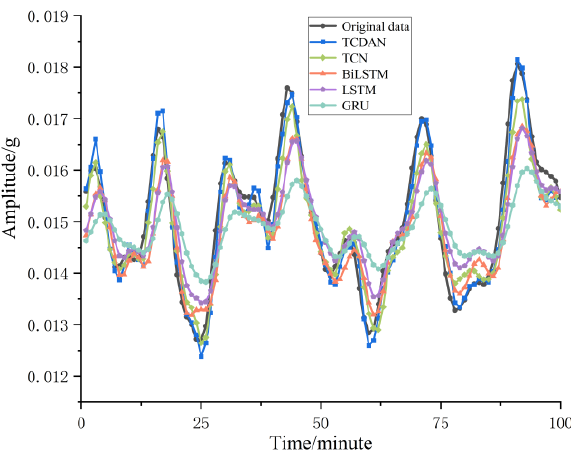
Figure 13. Prediction comparison of the amplitude corresponding to 2 × fo.